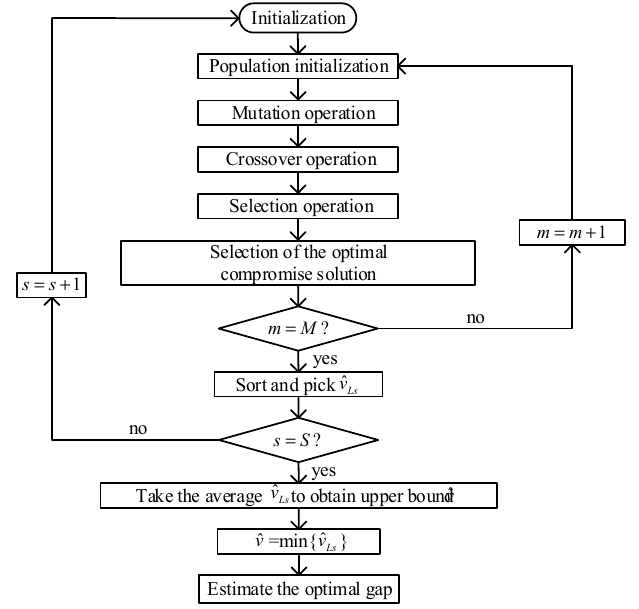
Figure 2. Proposed SAA algorithm combined with MODE.